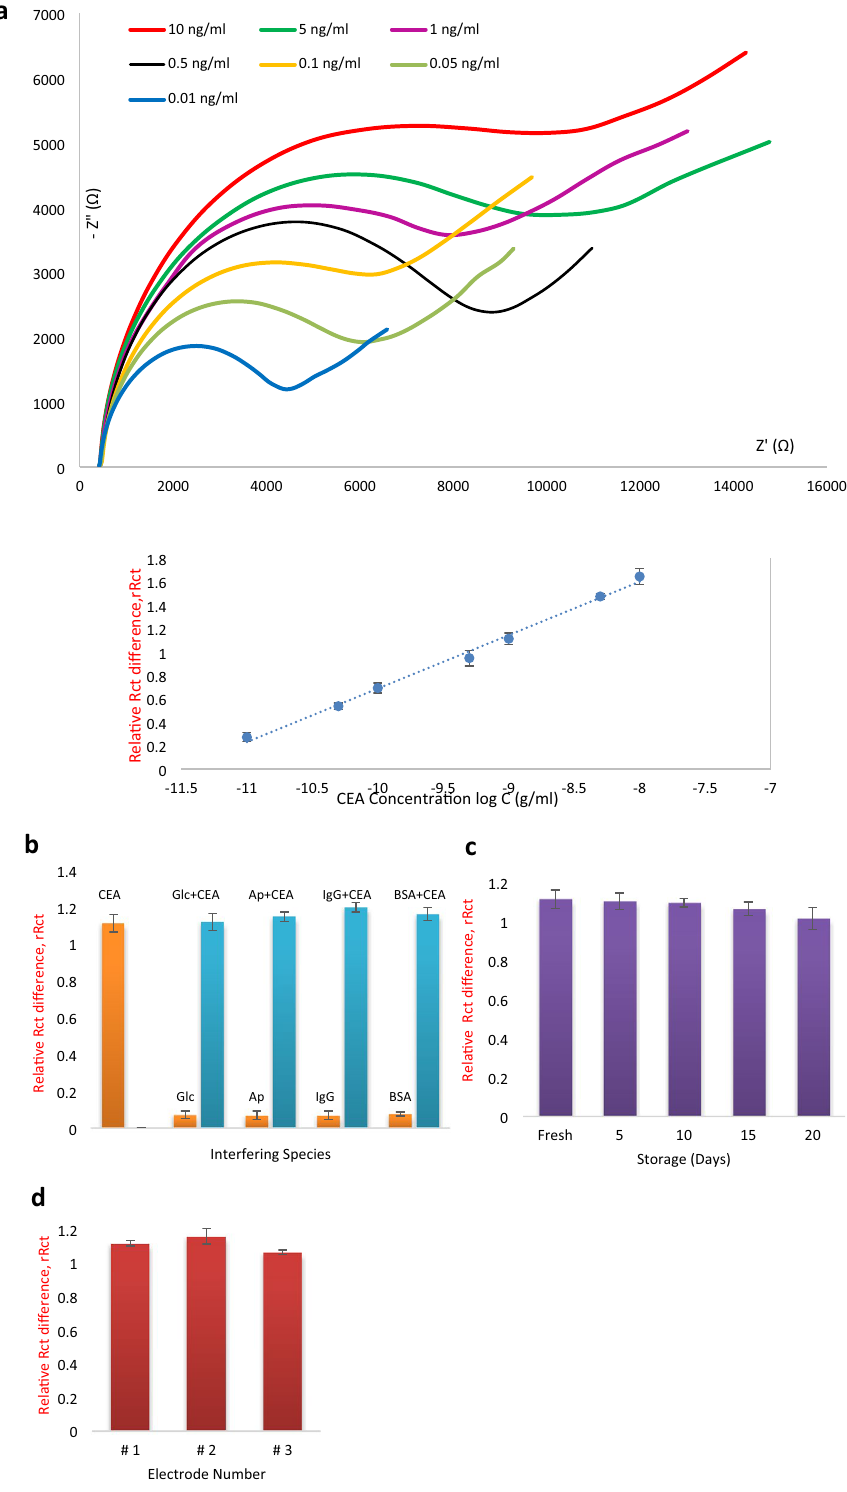
Figure 6. ( a ) EIS of CEA/SM/Ab/GZ-PYSE/PE tested with different concentrations of CEA ranging from 0.01 to 10 ng/ml. Inset: linear correlation between rRct and logarithmic value of CEA concentration, ( b ) specificity study of the immunosensor, ( c ) stability study of the immunosensor and ( d ) reproducibility assessment of the immunosensor. The fabricated immunosensor was specific to CEA and demonstrated reproducibility of 4.27% RSD with good stability. The sensor was able to quantity CEA ranging from 0.01 to 10